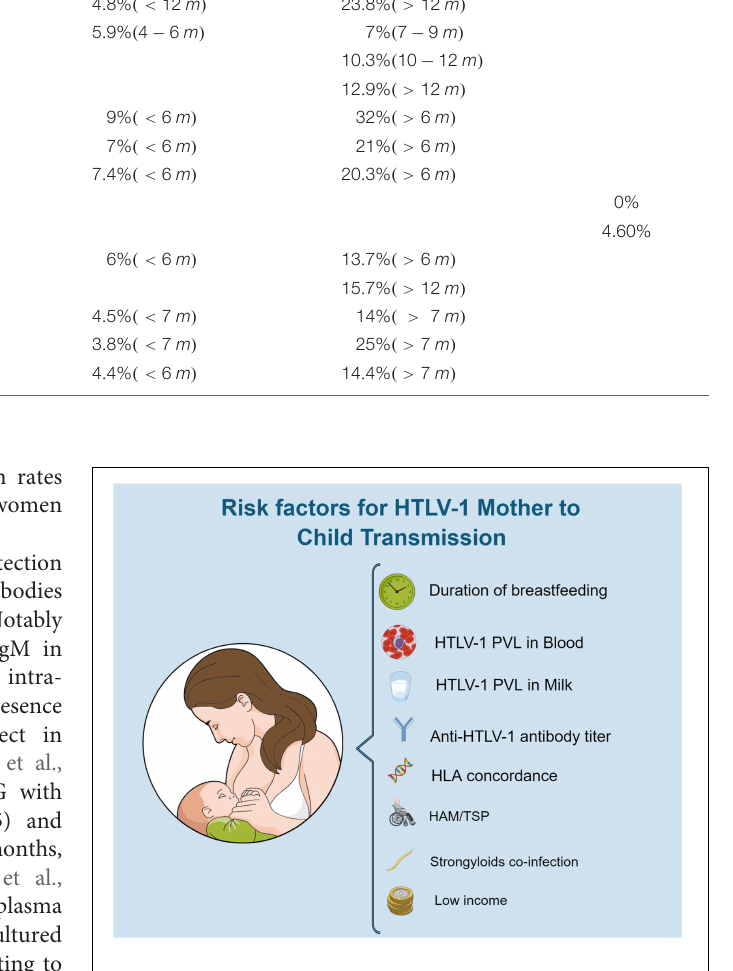
FIGURE 3 | Risk factors for HTLV-1 mother to child transmission. Original figure created with mindthegraph.